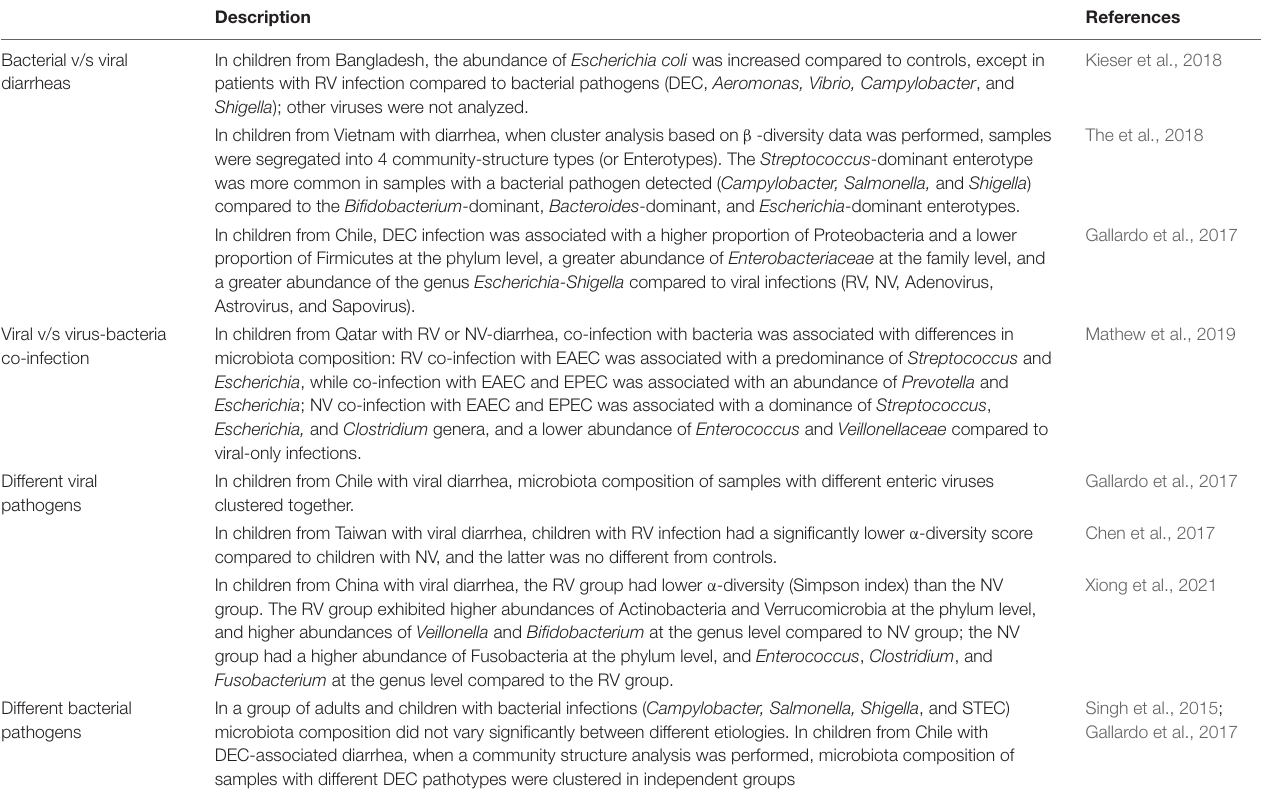
TABLE 5 | Differences in the gut microbiota composition during childhood infectious diarrhea according to etiology.